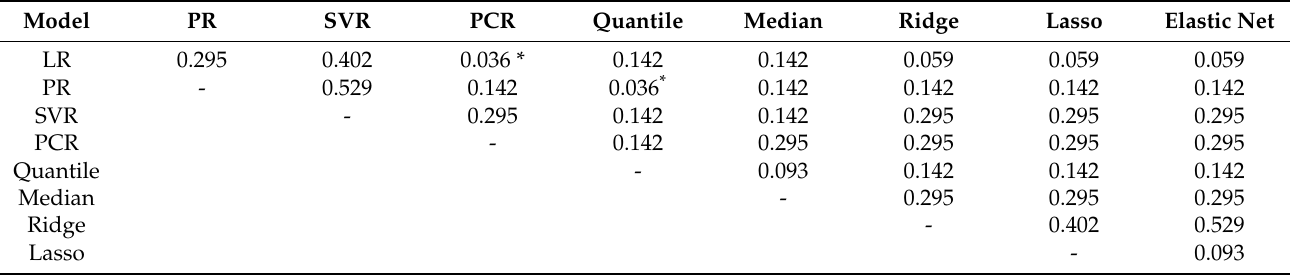
Table 9. Calculated p -values of Wilcoxon test for MRR in